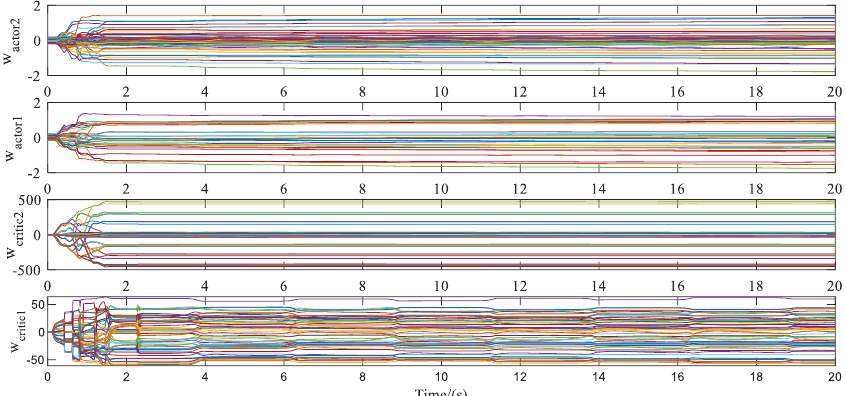
Figure 7. Weights updating of actor NN and critic NN. The parameters of neural networks converge to a steady state at about 1.4 s.